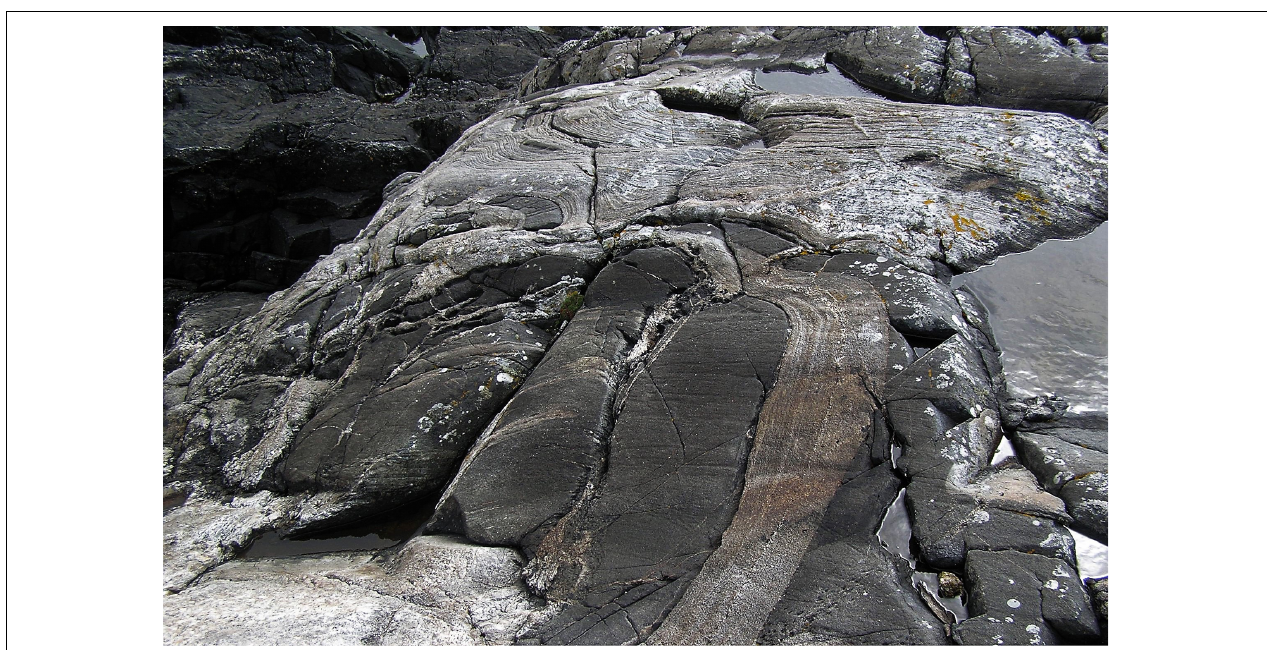
FIGURE 9 | Raft diatexite, Lewisian Complex of the North Atlantic Craton, Outer Hebrides, NW Scotland. At the start of the metatexite-diatexite transition, leuco- or mesocratic flow bands of diatexite disaggregates the original rock and isolates meter-scale blocks of amphibolite that often show rounded ends. Smaller rafts (schollen) are visible on the left. Photo: Pekka Kivimäki.